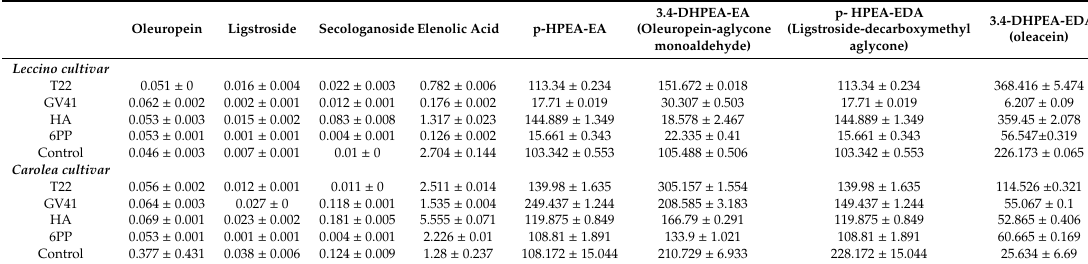
Table 3. Content of secoiridoids in EVOO (mg / kg).